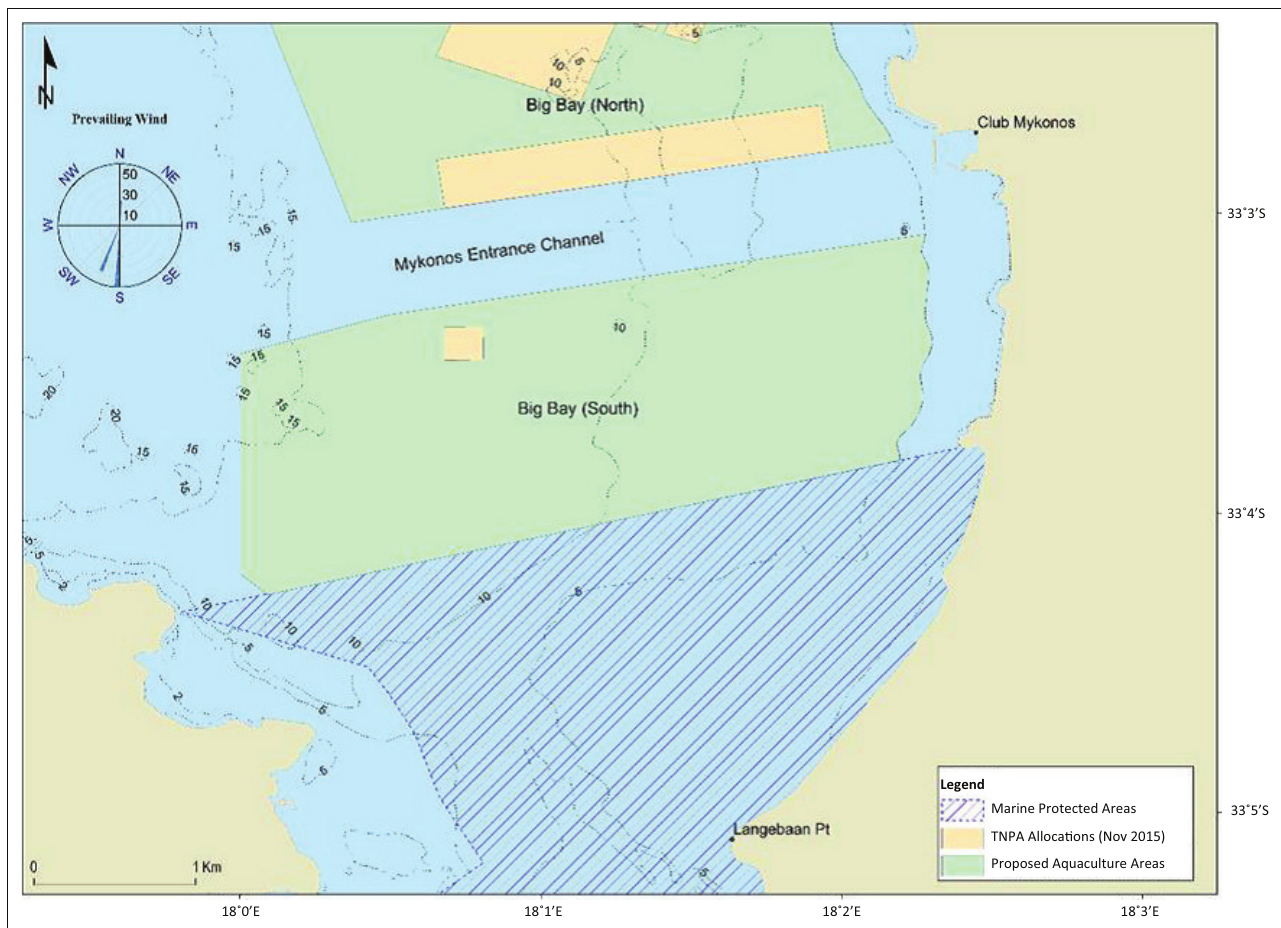
FIGURE 5: Proposed aquaculture development zones in Big Bay – South of